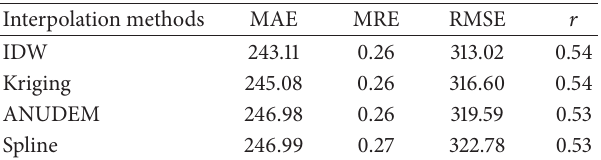
Table 2: Interpolation errors of annual